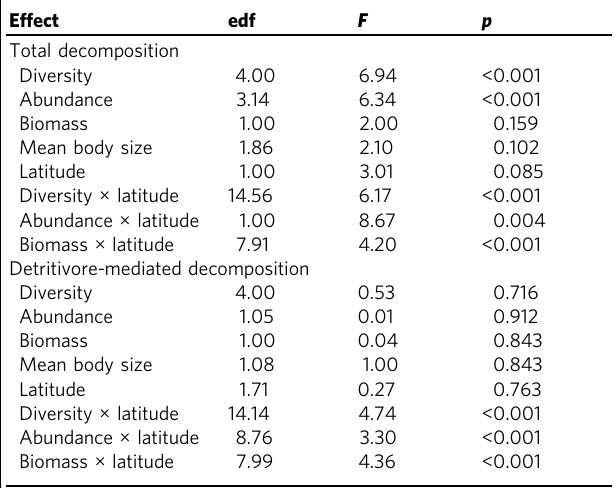
Table 1 Results of the best additive models explaining variation in total and detritivore-mediated litter decomposition based on detritivore diversity, abundance, biomass, mean body size, latitude, and interactions between detritivore variables and